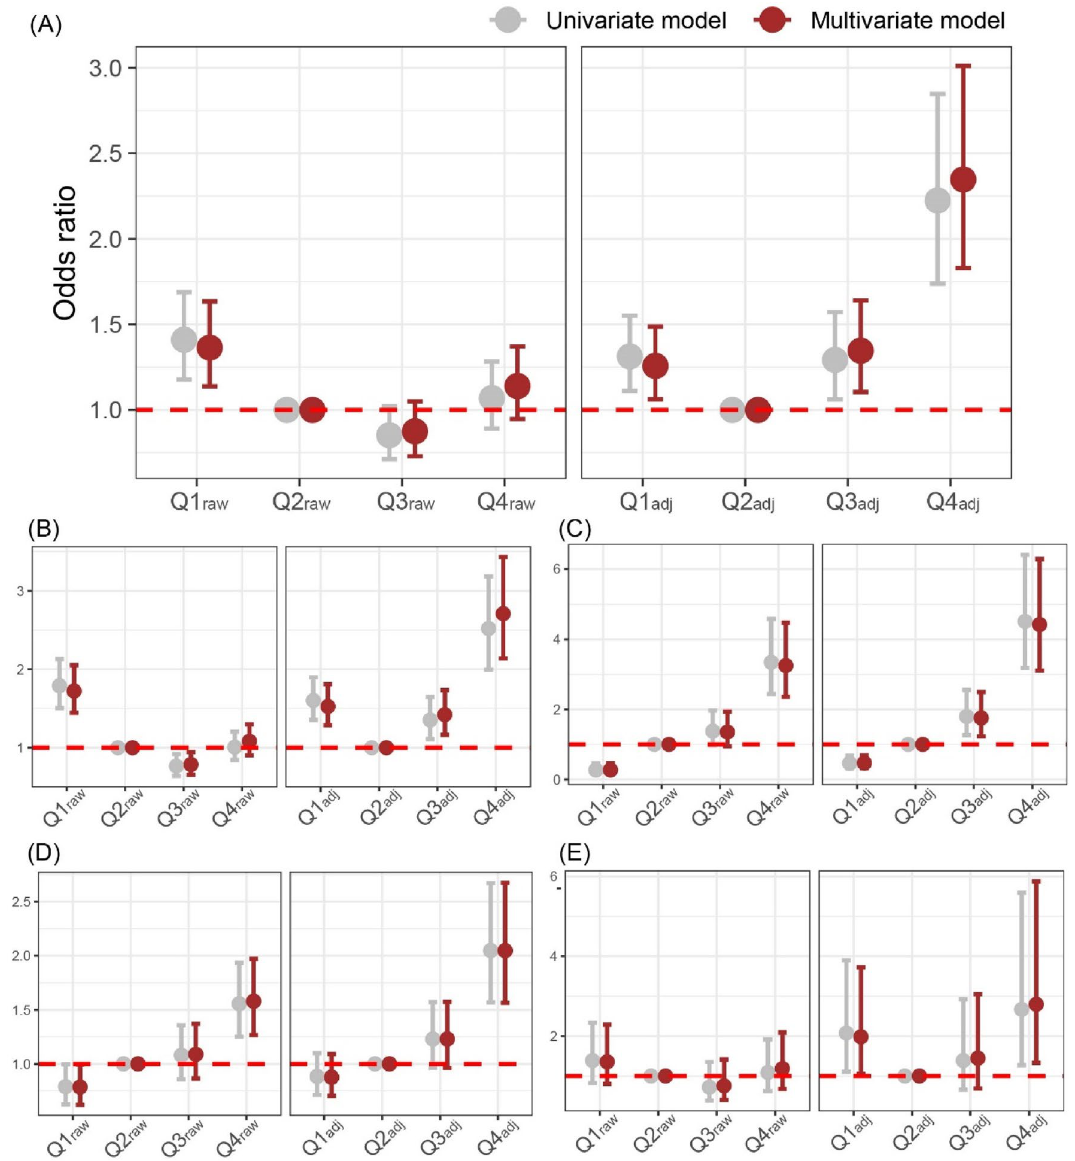
Figure 4. Logistic regression. Q2 raw and Q2 adj were used as references in all models. Age, hypertension, diabetes, and parity types are covariates for multivariate models. Logistic regression method was used to reveal the relationship between main outcome and four groups based on serum creatinine measurements. Relationship of the four SCr groups with all types of adverse pregnancy outcomes ( A ), preterm birth ( B ), preeclampsia ( C ), fetal growth retardation ( D ), and intrauterine fetal demise ( E ) are